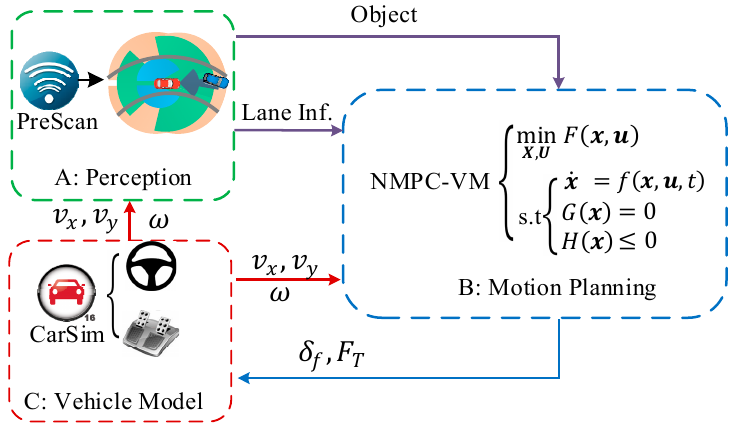
Figure 11. Block diagram of connection among modules of simulation system.